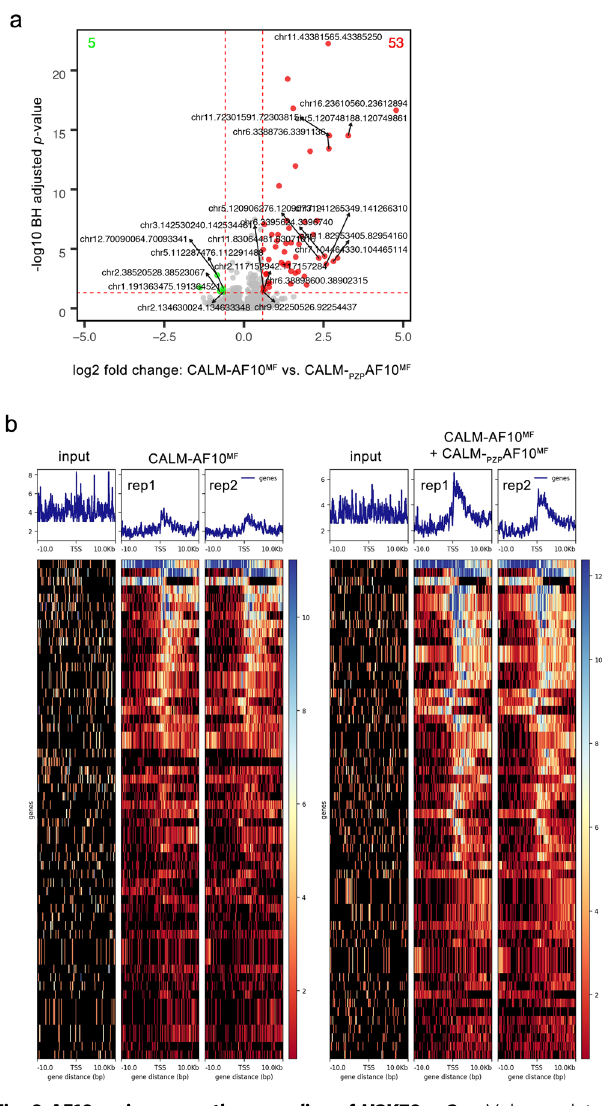
Fig. 9 AF10 PZP increases the spreading of H3K79me2. a Volcano plot showing genomic regions with differential H3K79me2 distribution in CALM-AF10 MF leukemia cells and in the same cells expressing CALM- PZP AF10 MF . Red dots represent regions that gained H3K79me2, green dots represent regions that lost H3K79me2 peaks, and gray dots represent the regions with statistically insigni fi cant changes in H3K79 methylation upon CALM- PZP AF10 MF expression. BH: Benjamini Hochberg. b Meta-analysis of H3K79me2 centered around the transcription start site (TSS) of loci with differential H3K79me2 distribution in CALM-AF10 MF samples (left) compared to CALM-AF10 MF + CALM- PZP AF10 MF samples (blue plots) is shown above corresponding heatmaps. Y -axis represents genes, whereas X -axis shows the distance in base pair (bp) from the TSS for each gene. Peak density increases from blue to red. The left three panels and the right three panels show input and two replicates of CALM-AF10 MF and CALM-AF10 MF + CALM- PZP AF10 MF samples,